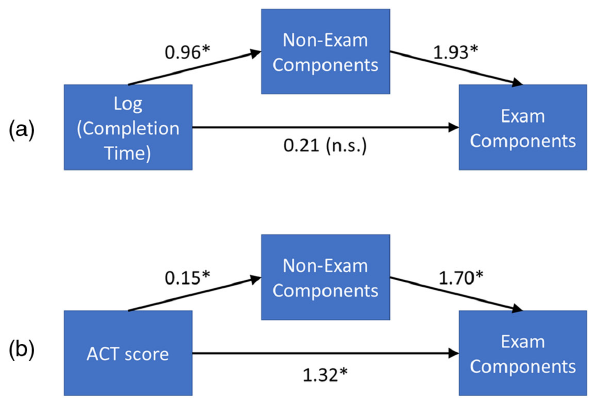
FIG. 8. Mediation model path diagrams depicting the total, direct, and indirect effects of (a) log completion time on exam components and (b) ACT score on exam components with the indirect effect operating through a single mediator, nonexam components. [* p < 0 . 001 . (n.s) = not significant.]